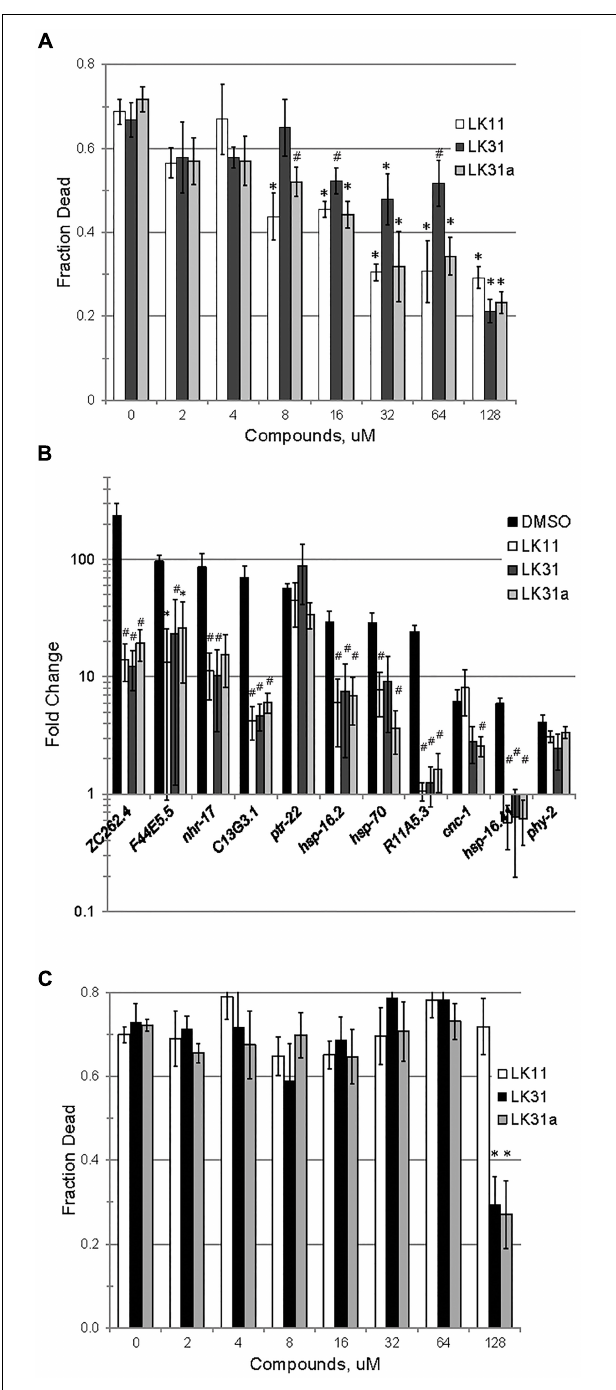
FIGURE 7 | LK11, LK31, and LK31a inhibit pyoverdine-mediated pathology. (A) Liquid Killing of C. elegans was assayed in the presence of varying doses of LK11, LK31, and LK31a. (B) qRT-PCR showing expression of a panel of genes upregulated by pyoverdine exposure during Liquid Killing of C. elegans treated with LK11, LK31, or LK31a (100 µ M). (C) Liquid Killing of C. elegans exposed to P. aeruginosa strain PA14 pvdF , which is defective in pyoverdine biosynthesis, and treated with LK11, LK31, or LK31a at the concentrations indicated. At least three biological replicates were performed for A–C